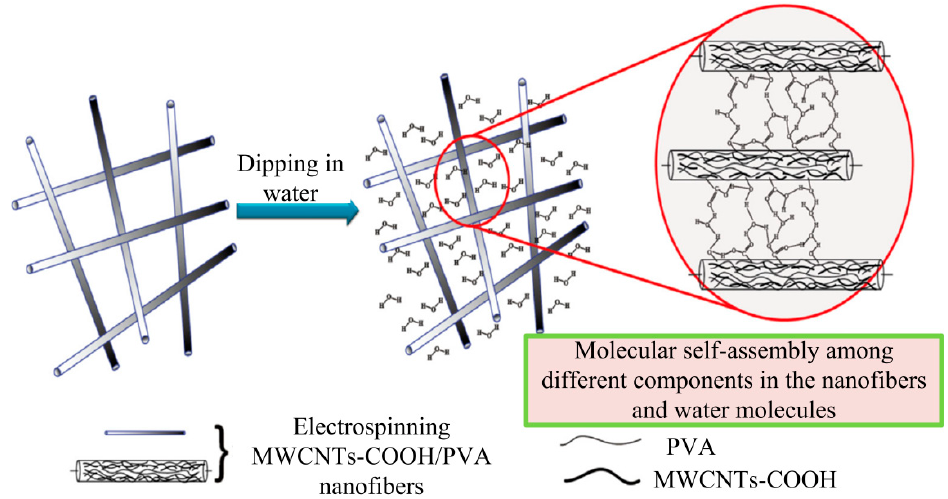
Figure 7. Scheme of self-assembly of transparent conductive composite films from nanofibers (Adapted from [79] ).